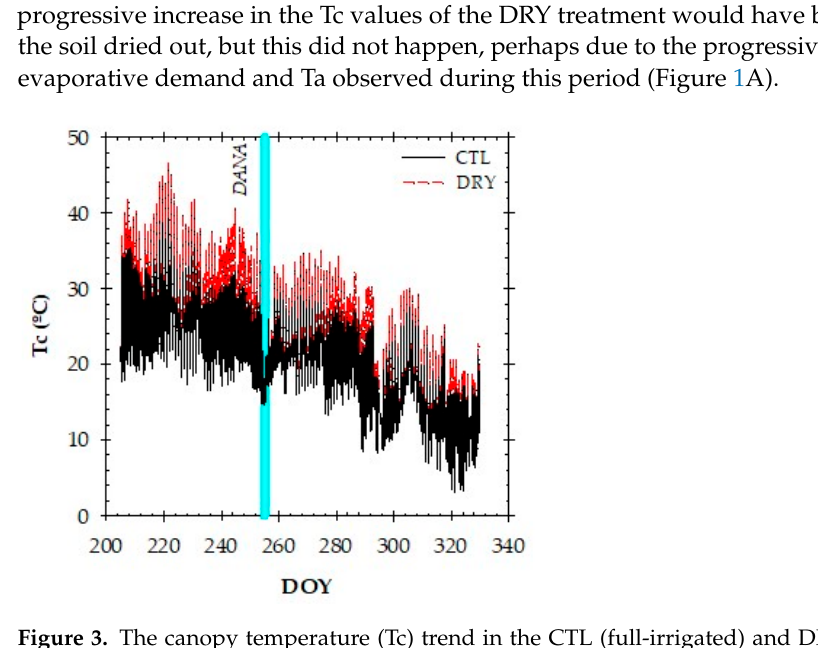
Figure (cid:561) 3. (cid:561) The (cid:561) canopy (cid:561) temperature (cid:561) (Tc) (cid:561) trend (cid:561) in (cid:561) the (cid:561) CTL (cid:561) (full (cid:442) irrigated) (cid:561) and (cid:561) DRY (cid:561) (non (cid:442) irrigated) (cid:561) Figure 3. The canopy temperature (Tc) trend in the CTL (full-irrigated) and DRY (non-irrigated) treatments. (cid:561) Values (cid:561) are (cid:561) the (cid:561) average (cid:561) of (cid:561) 15 (cid:442) min (cid:561) recordings (cid:561) of (cid:561) three (cid:561) infrared (cid:561) radiometer (cid:561) sensors. (cid:561) The (cid:561) treatments. Values are the average of 15-min recordings of three infrared radiometer sensors. The solid (cid:561) vertical (cid:561) cyanline (cid:561) indicates (cid:561) the (cid:561) DANA (cid:561) event. (cid:561) solid vertical cyan line indicates the DANA Since (cid:561) Tc (cid:561) is (cid:561) influenced (cid:561) by (cid:561) atmospheric (cid:561) conditions (cid:561) such (cid:561) as (cid:561) the (cid:561) vapor (cid:561) pressure (cid:561) deficit (cid:561) and (cid:561) radiation (cid:561) level (cid:561) among (cid:561) others (cid:561) [12], (cid:561) the (cid:561) use (cid:561) of (cid:561) Tc (cid:561) as (cid:561) a (cid:561) plant (cid:561) water (cid:561) status (cid:561) indicator (cid:561) re (cid:556)